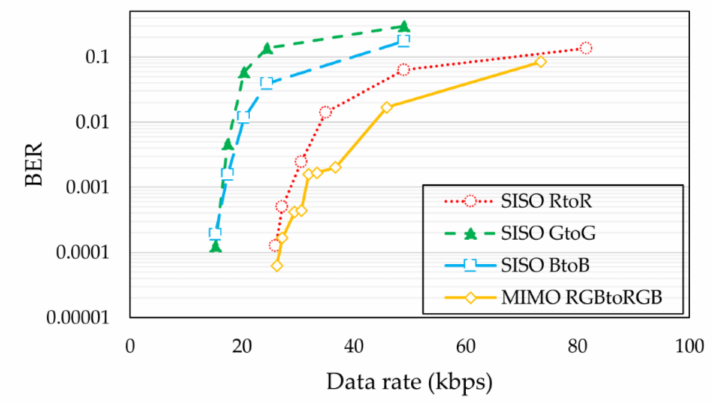
Figure 9. BER of the SISO LED-to-LED systems and 3 × 3 MIMO LED-to-LED system.